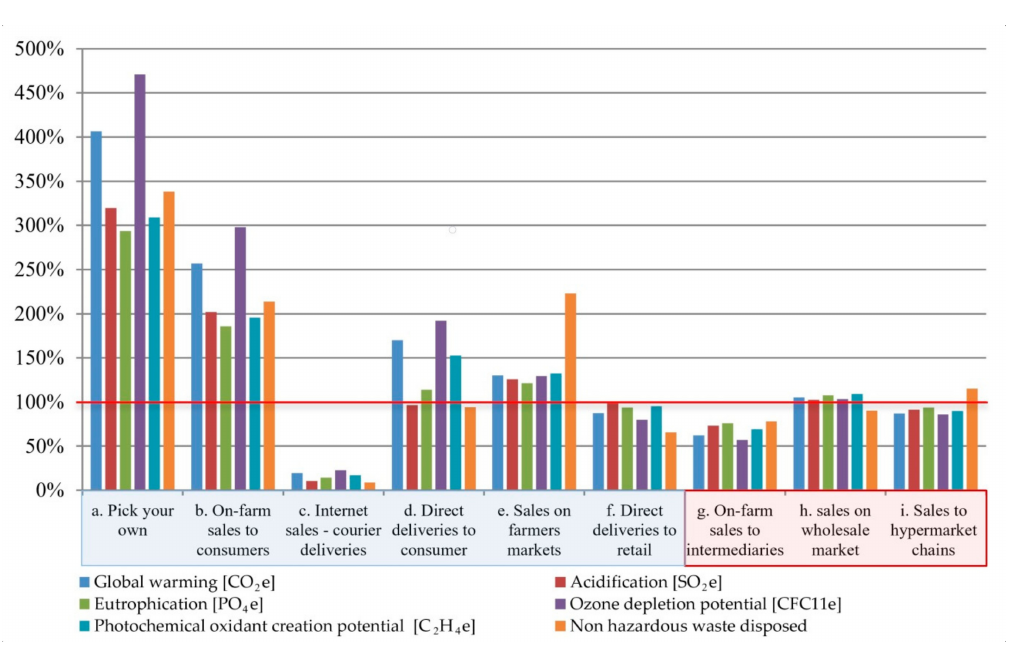
Figure 3. Relative eco-e ffi ciency indicators (emissions per 1 kg of product) for supply chains related to weighted mean value = 100%. Source: own